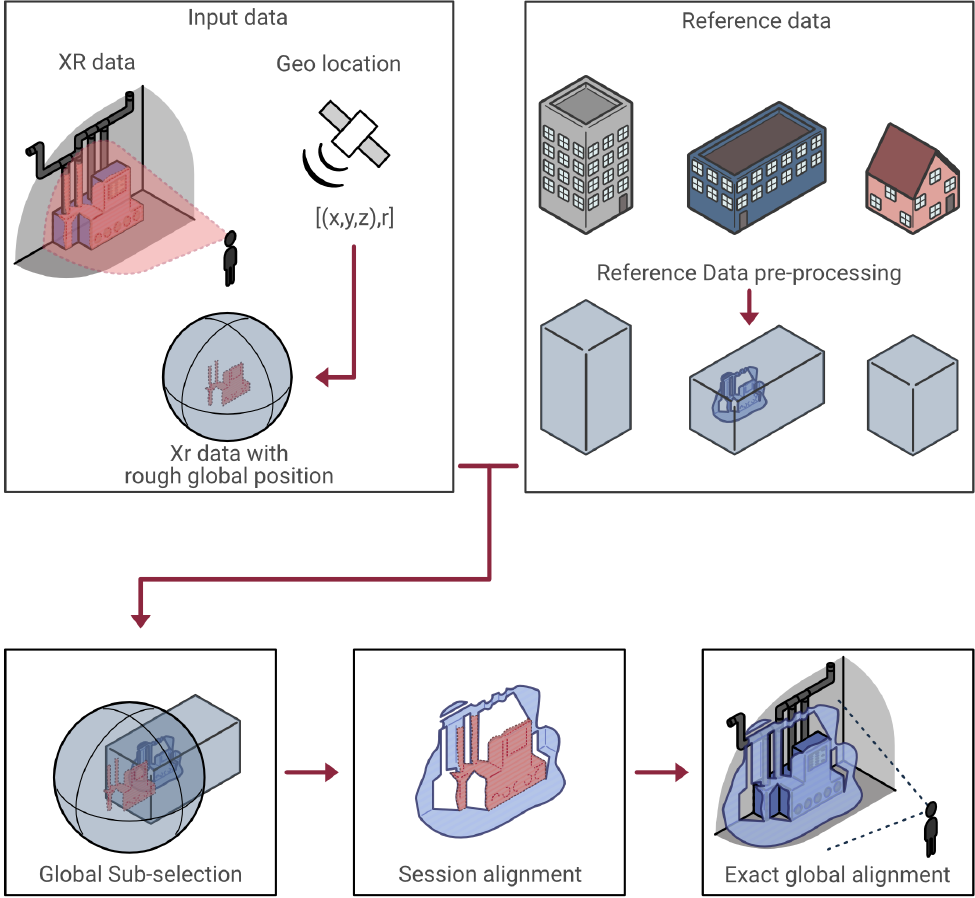
Figure 2. Overview of the proposed two-step alignment process based on both image and geometric